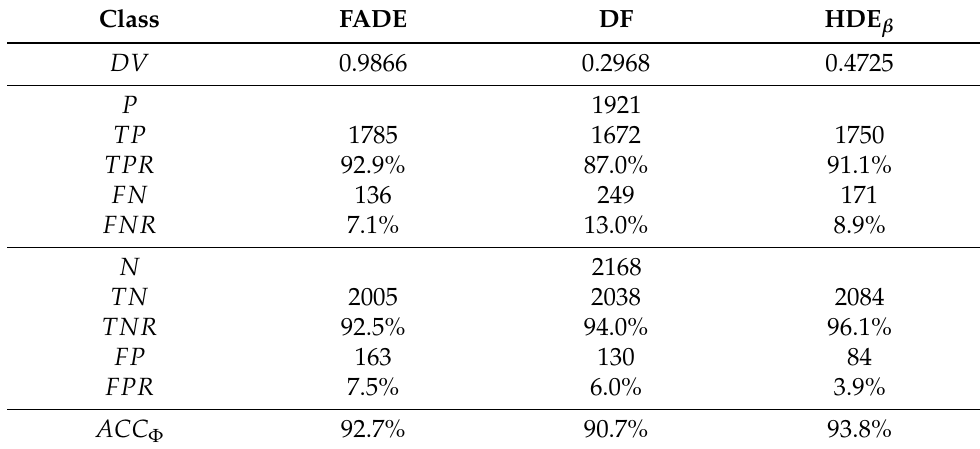
Table 4. The accuracy report for the hazy/haze-free image classification task using haze density eval-